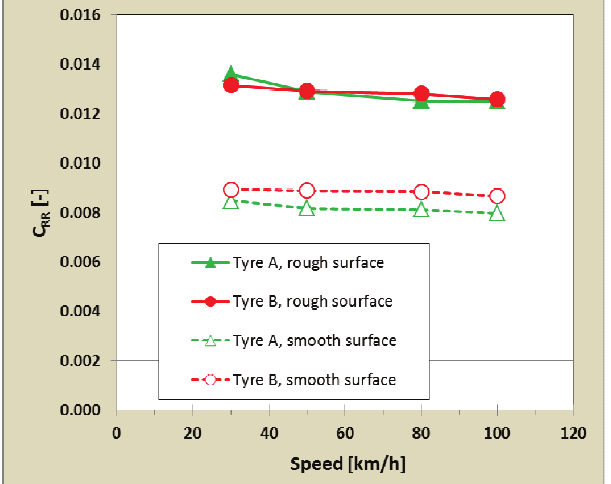
Fig. 2. Speed influence on tyre rolling resistance (results of laboratory measurements performed according to ISO